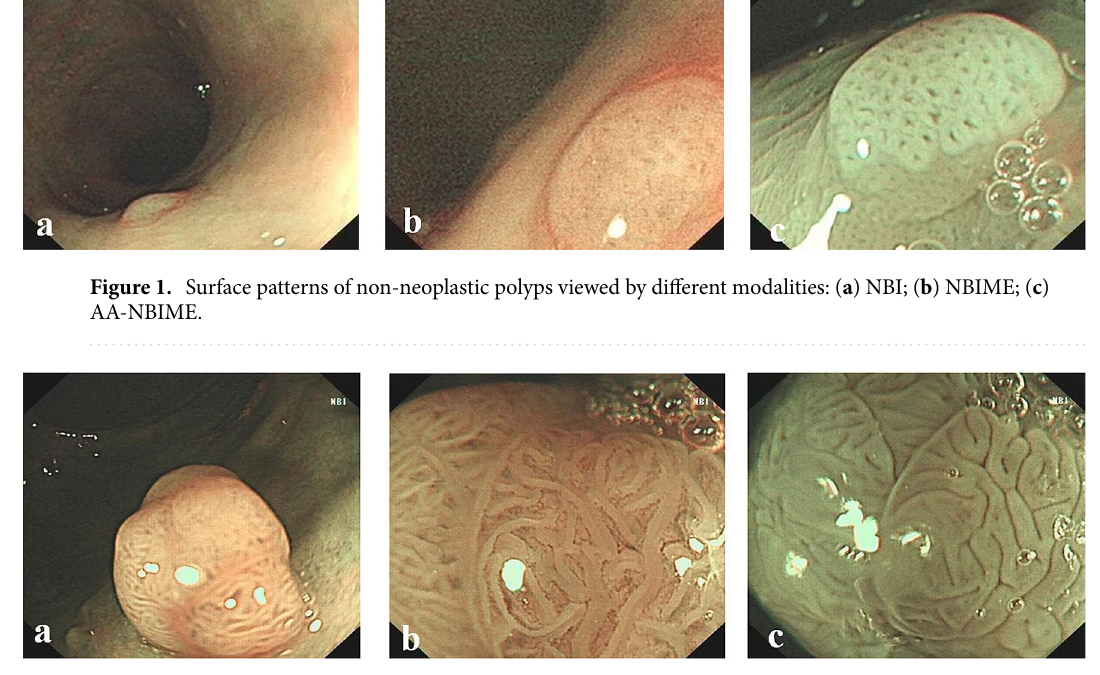
Figure 2. Surface patterns of neoplastic polyps viewed by different modalities: ( a ) NBI; ( b ) NBIME; ( c )